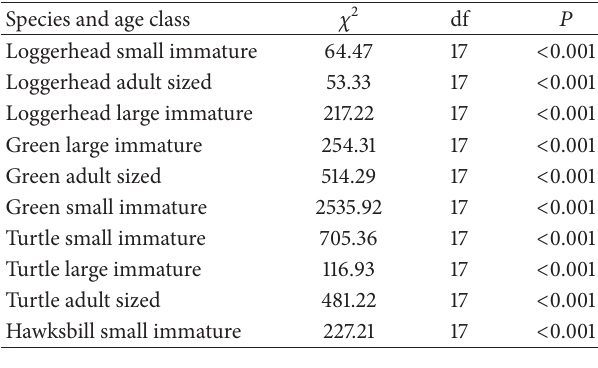
Table 1: Chi-squared total strandings by species and age class between years.